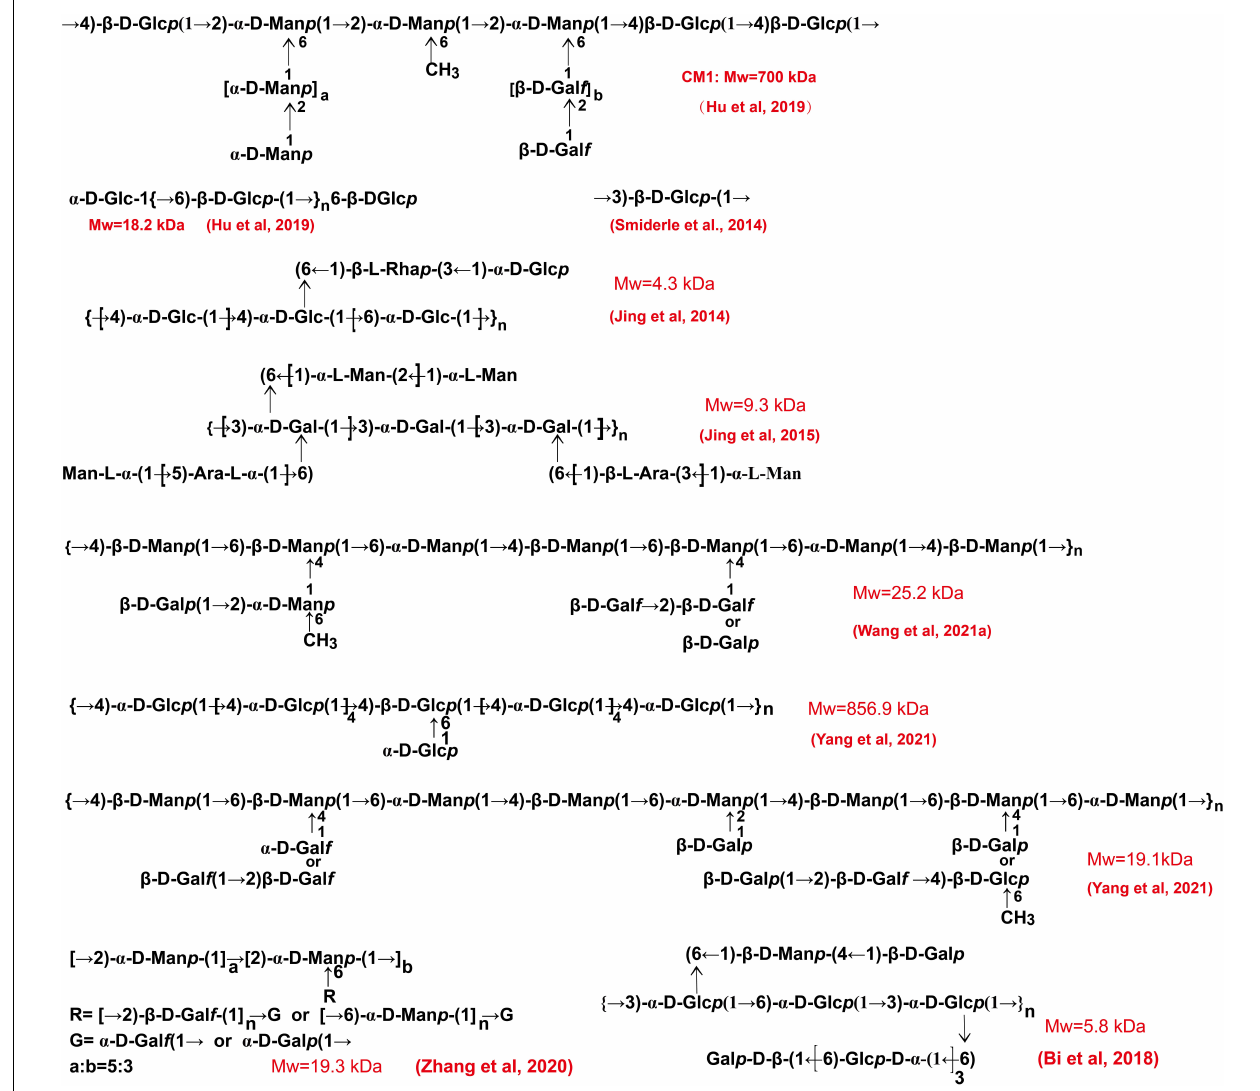
FIGURE 6 | The chemical structures of polysaccharides derived from the fruiting body of C. militaris . These structures are obtained from related